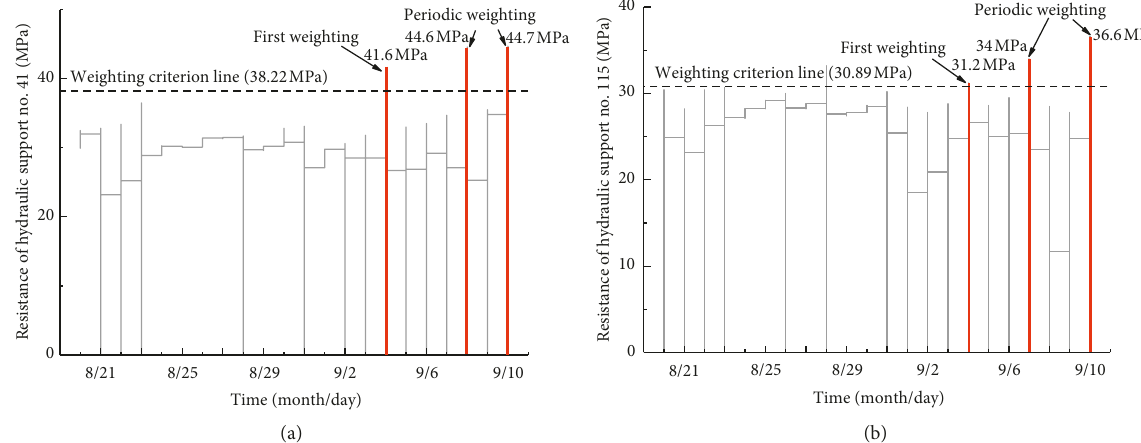
Figure 9: Working resistance of the hydraulic support in the working face. Resistance of (a) hydraulic support no. 41 and (b) hydraulic support no.